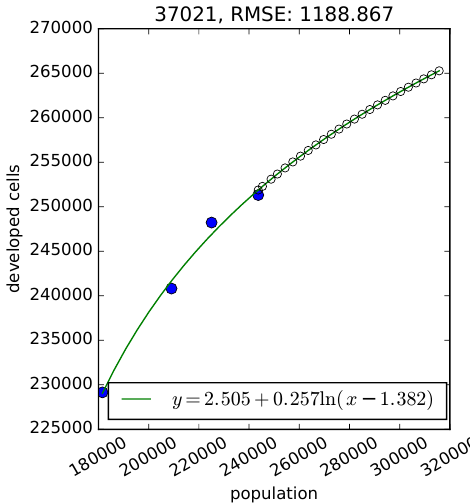
Figure 3: An example of r.futures.demand output plot showing the logarithmic relation between population and land consumption for the county with ID 37021. Observed data are showed as blue dots and predicted data as